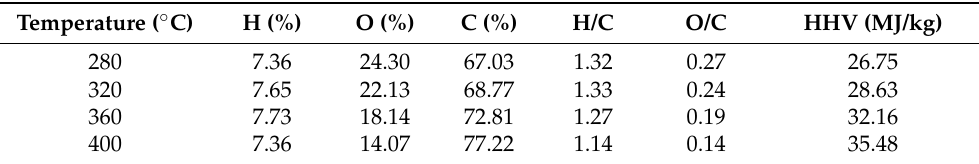
Table 4. The effect of temperature on the elemental composition, atomic ratios and Higher Heating Value (HHV) of biofuel